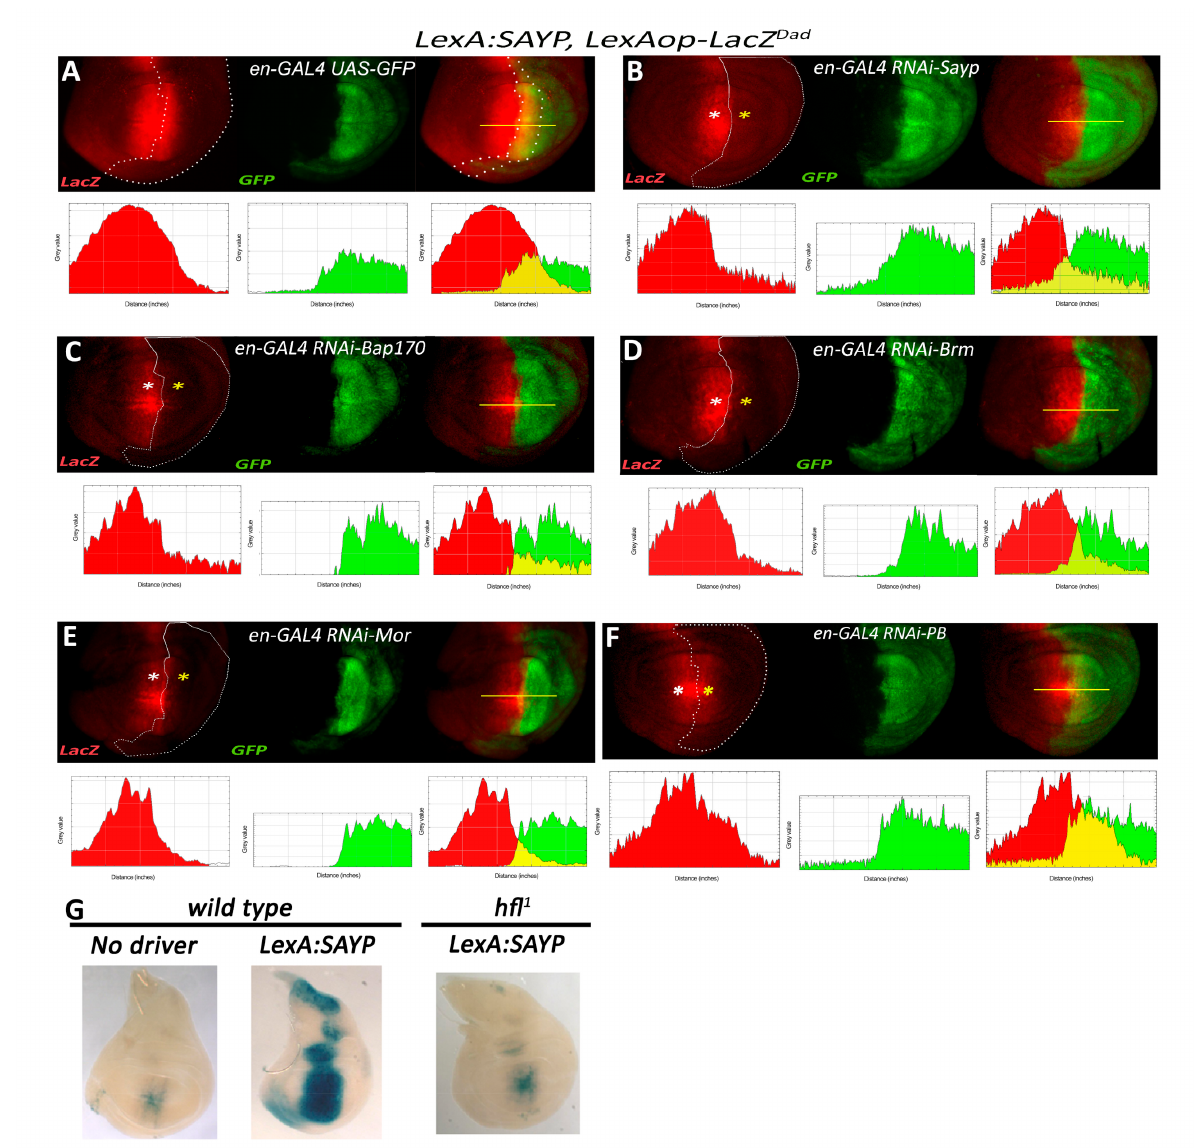
Figure 6. Enhancer-dependent transcriptional activation mediated by SAYP requires BAP170 and key components of the PBAP complex core. Fluorescence imaging of beta-gal (red) and GFP (green) expression in wing discs from larvae of the genotype en-GAL4, UAS-GFP/+ ; P BAP170 -LexA:SAYP , LexAop-LacZ Dad /+ transgenes alone ( A control) or in combination with RNAi lines for SAYP ( B ), BAP170 ( C ), BRM ( D ), MOR ( E ), and PB ( F ). ( A ) Control wing disc from en-Gal4 , UAS-GFP/+ ; P BAP170 -LexA:SAYP , LexAop-LacZ Dad /+ without RNAi. The Dad -like expression pattern of the SAYP-induced LexAop-LacZ Dad transgene overlaps posterior expression of en-GAL4 in a GFP-positive posterior row of cells flanking the A/P axis (cells included in the dotted line in merge image). White asterisks indicate the regions with normal LexAop-LacZ Dad transgene expression (outside the induced RNAi region), and yellow asterisks indicate the regions with expression of RNAi lines and altered target LexAop-LacZ Dad transgene activation. Genotypes: ( B ) en-GAL4,UAS-GFP/+ ; P BAP170 -LexA:SAYP , LexAop- LacZ Dad /UAS-RNAi-SAYP [Vdrc105946] , ( C ) en-GAL4,UAS-GFP/+ ; P BAP170 -LexA:SAYP , LexAop-LacZ Dad /UAS-RNAi-BAP170 [Vdrc34582] , ( D ) en-GAL4,UAS-GFP/+ ; P BAP170 -LexA:SAYP , LexAop-LacZ Dad /UAS-RNAi-Brm [Vdrc37721] , ( E ) en-GAL4,UAS- GFP/+ ; P BAP170 -LexA:SAYP , LexAop-LacZ Dad /UAS-RNAi-Mor [Vdrc6969] , ( F ) en-GAL4,UAS-GFP/+ ; P BAP170 -LexA:SAYP , LexAop-LacZ Dad /UAS-RNAi-PB [Vdrc108618] . The plots under each wing disc panel show the intensity of staining for each color along the line at the antero/posterior boundary (yellow line in each left merged image). A dotted line encompasses the area of GFP expression. ( G ) Beta-gal activity in wing discs from larvae with the LexAop-LacZ Dad responder alone ( left ) or combined with P BAP170 -LexA:SAYP in the wild type ( center ) or the BAP170 null mutant background hfl 1 /hfl 1 ( right